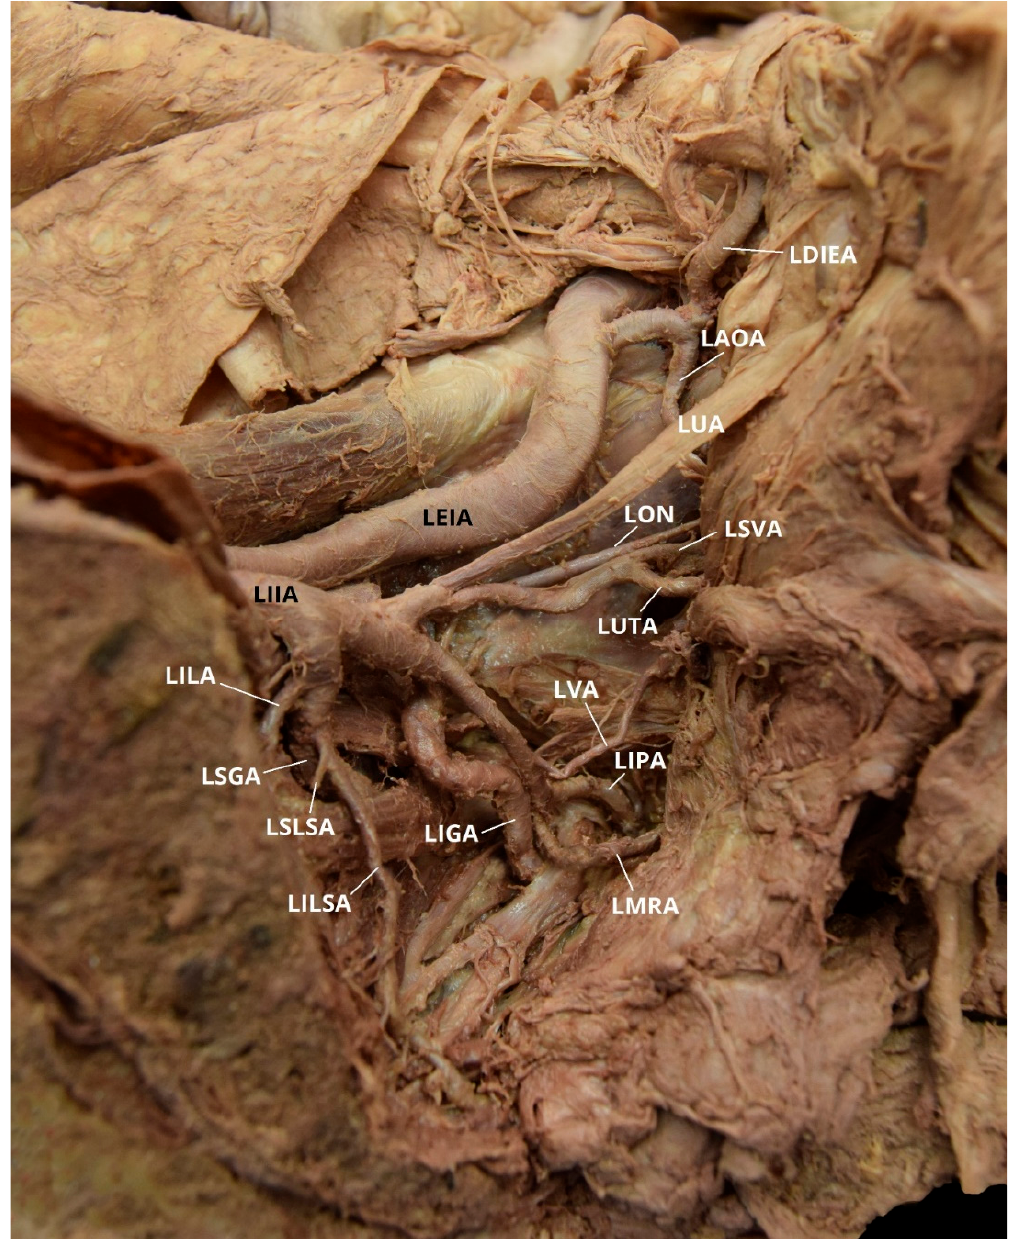
Figure 5. Facilitated display highlighting the left internal iliac artery branches with the left aberrant obturator artery for Case 3. LAOA = Left Aberrant Obturator Artery; LDIEA = Left Deep Inferior Epigastric Artery; LEIA = Left External Iliac Artery; LIGA = Left Inferior Gluteal Artery; LIIA = Left Internal Iliac Artery; LILA = Left Iliolumbar Artery; LILSA = Left Inferior Lateral Sacral Artery; LIPA = Left Internal Pudendal Artery; LMRA = Left Middle Rectal Artery; LON = Left Obturator Nerve; LSGA = Left Superior Gluteal Artery; LSLSA = Left Superior Lateral Sacral Artery; LSVA = Left Superior Vesical Artery; LUA = Left Umbilical Artery; LUTA = Left Uterine Artery; LVA = Left Vaginal Artery.